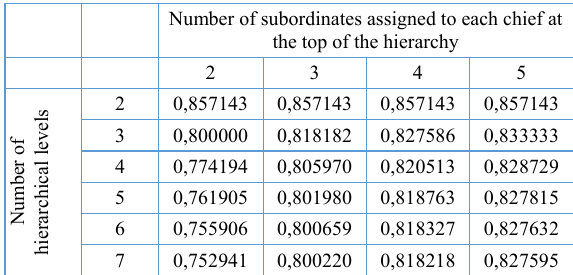
Table 4. Hierarchy efficiency in organizations with w=6, a different number of hierarchical levels and ratios of headship.